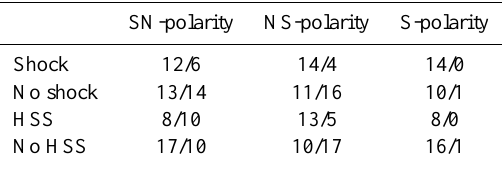
Table 6. Distribution of geoeffective and non-geoeffective SN, NS and S-polarity clouds to cases that were related to a shock and a higher-speed trailing stream (HSS) and those that were not. The first number for each type indicates geoeffective cases and the sec- ond number non-geoeffective cases. Note that in this table we have grouped together original and reversed types. For example, column “SN” includes original-SN and reversed-NS